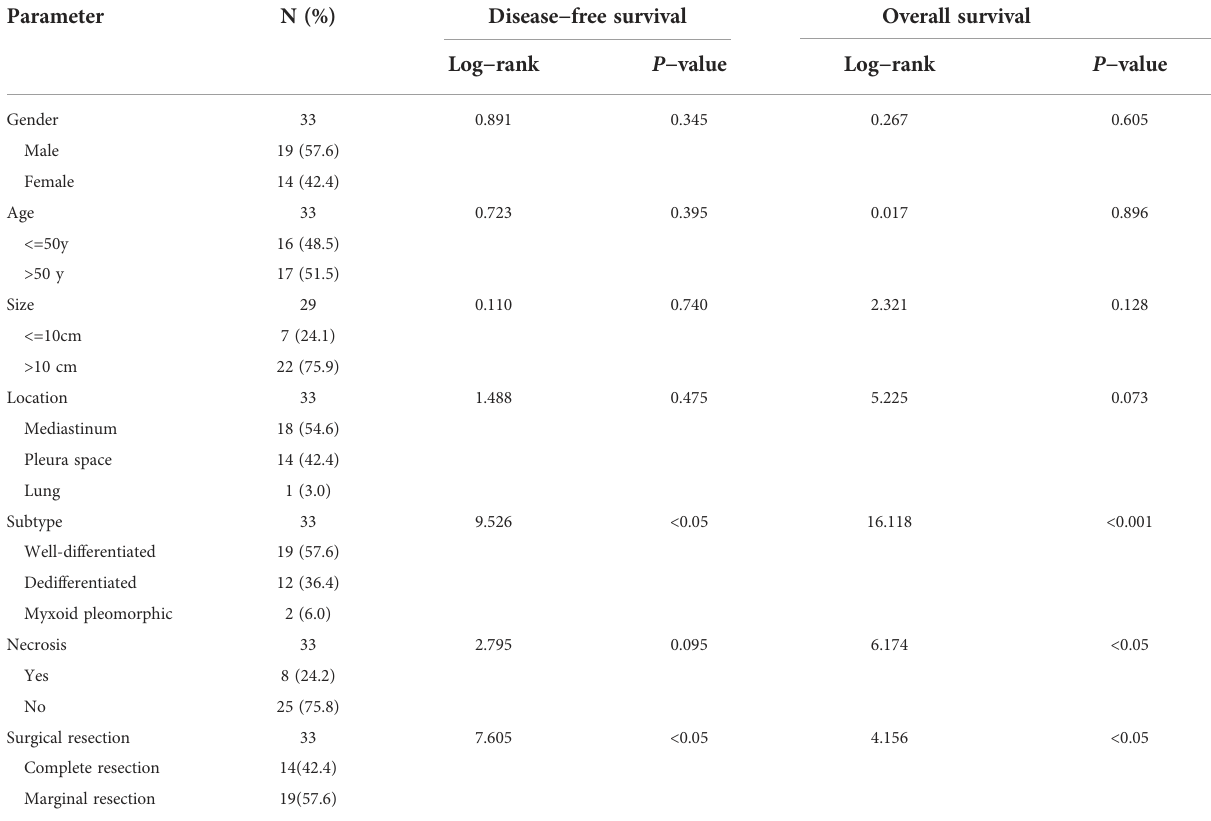
TABLE 2 Survival data of the primary intrathoracic liposarcoma patients of the study.